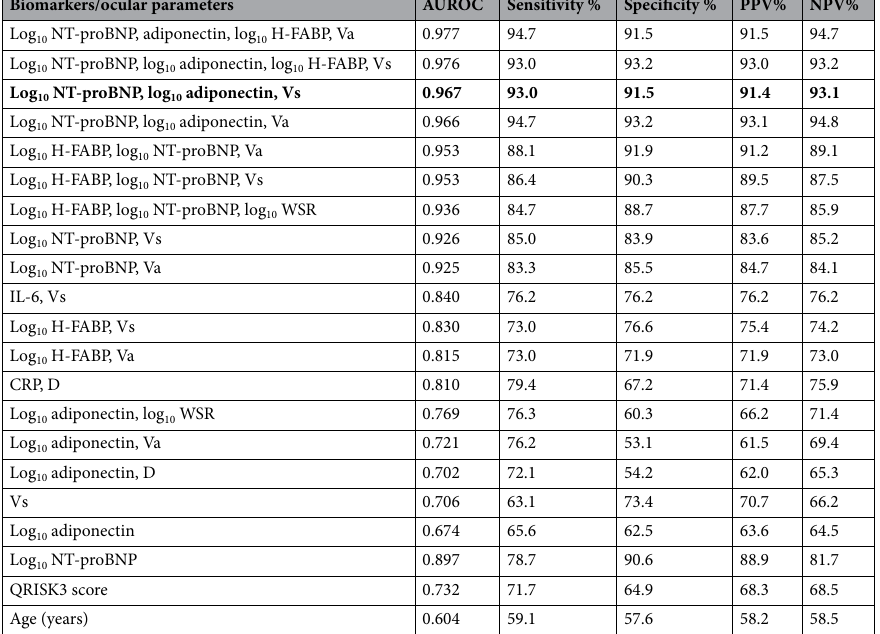
Table 4. Multivariate logistic regression with biomarkers and ocular parameters for detecting CAD. Significant values are in bold. CRP C-reactive protein, H-FABP heart-type fatty acid-binding protein, IL-6 positive predictive value, NPV negative predictive value.